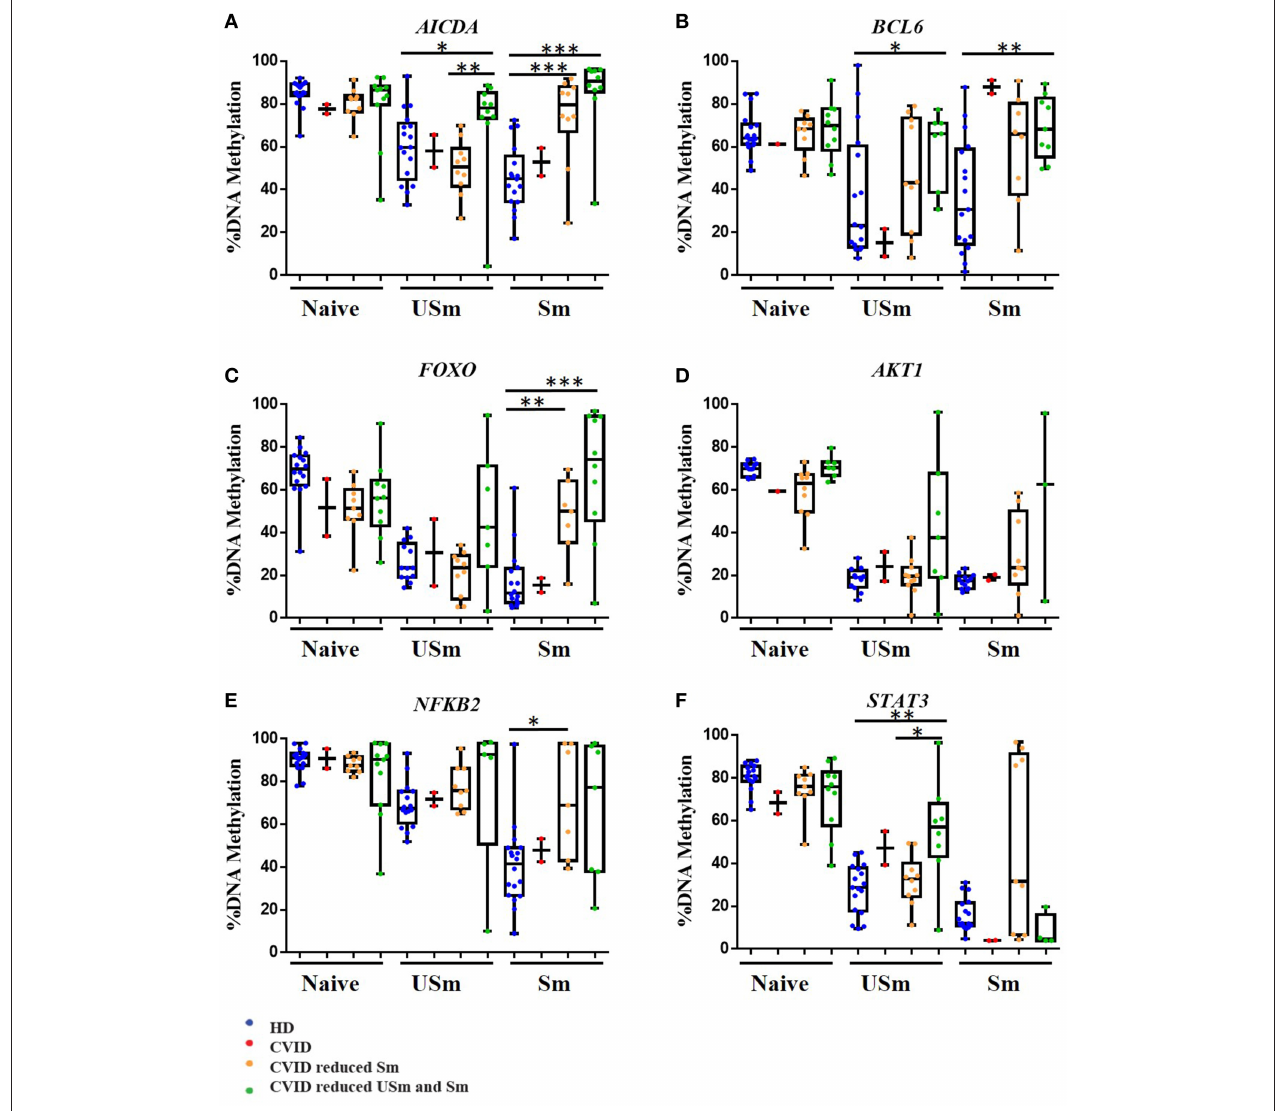
FIGURE 2 | DNA methylation levels for the selected CpG in different genes, in the naïve, unswitched (USm) and switched (Sm) memory B cells represented as percentage in box and whiskers. HD are represented in blue. CVID patients with normal numbers of unswitched (USm) and switched (Sm) memory B cells in red, CVID patients with normal numbers of unswitched (USm) memory B cells but reduced switched (Sm) memory B cells in orange; in green CVID patients with reduced numbers of both unswitched (USm) and switched (Sm) memory B cells. Box represent mean with minimum to maximum. The P -value is shown for the cases with a statistically significant difference by Mann Whitney test (* p < 0.05; ** p < 0.01; *** p <